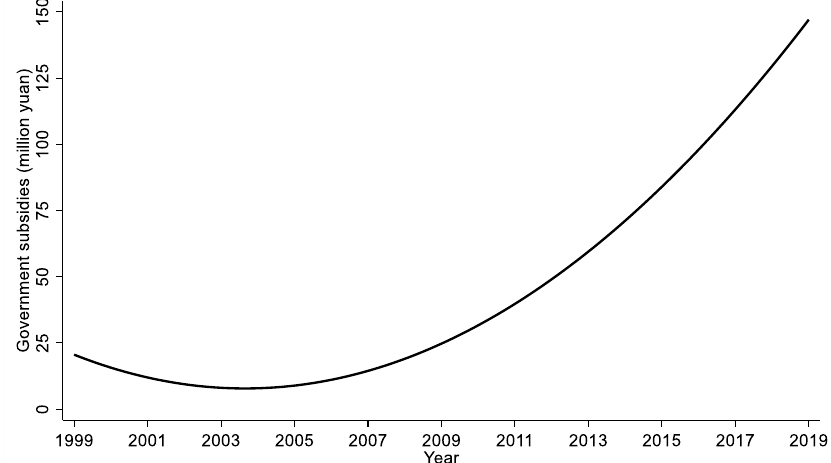
Figure 6. Change trend of government subsidies. (Source: Produced by the authors from the sample data using Stata 16.1).